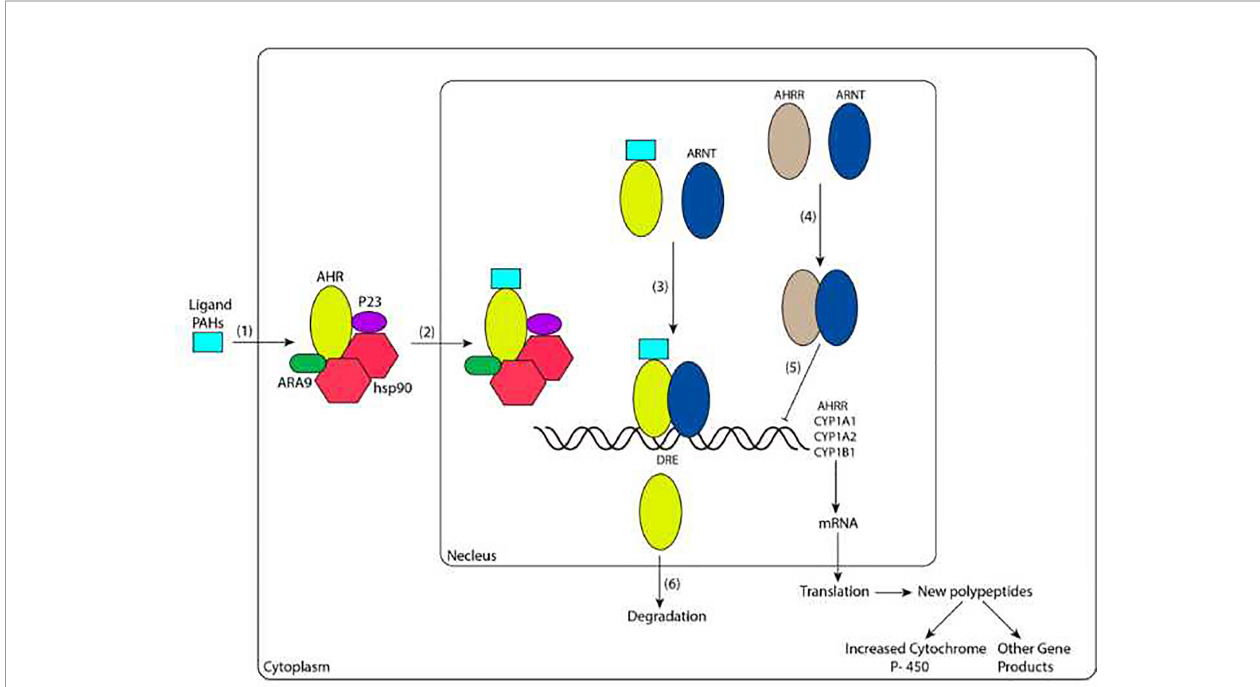
FIGURE 1 | Ligand-dependent signal transduction pathways of AHR activation. (1) The ligand diffuses into cells and binds to the AHR complex in the cytoplasm. (2) The ligand-bound receptor complex translocates into the nucleus. (3) The heterodimerization of AHR and ARNT enhances the binding ability with DREs. (4) AHRR binds to ARNT. (5) AHRR and ARNT dimers repress AHR transcriptional activity. (6) AHR is exported to the cytoplasm by nuclear exportation and degraded. CYP1A1, CYP1A2, and CYP1B1 are genes encoding the phase I enzyme P450. AHR, AHRR and ARNT are basic helix-loop-helix-PER-ARNT-SIM (bHLH-PAS) proteins, and AHRR and AHR have high sequence similarity. PAHs, polycyclic aromatic hydrocarbons; AHR, aromatic hydrocarbon receptor; hsp90, heat shock protein 90; ARNT, aromatic hydrocarbon receptor nuclear translocation; AHRR, aryl hydrocarbon receptor repressor; DRE, dioxin response element; CYP, cytochrome